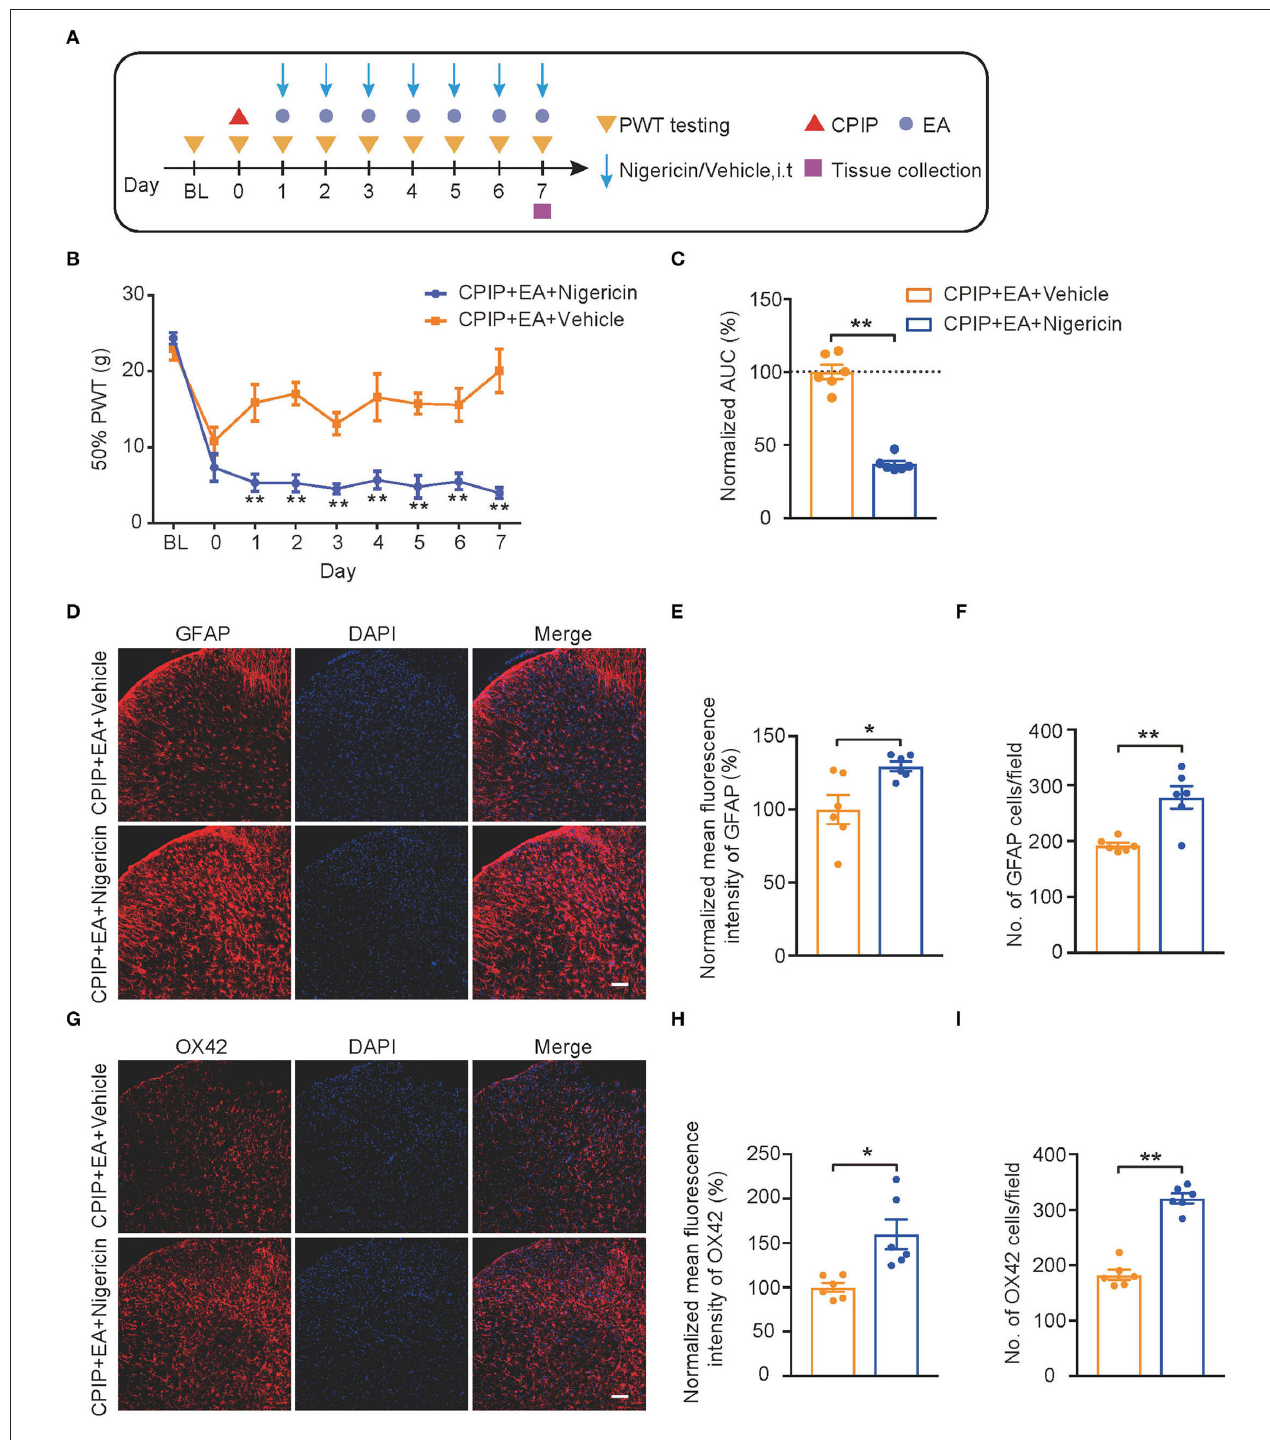
FIGURE 8 | EA-induced anti-allodynic effect in CPIP rats is reversed by NLRP3 inflammasome activator nigericin. (A) Experimental protocol. (B) Time course showing the effect of intrathecal nigericin on EA-induced anti-allodynia in CPIP rats. (C) Normalized AUC deduced from (B) . (D) Immunostaining of GFAP in ipsilateral SCDH after intrathecal nigericin/Veh injection. (E) Summary of the mean fluorescence intensity of GFAP. (F) Summary of the total number of GFAP + cells/observation field. (G) Immunostaining of OX42 in ipsilateral SCDH after intrathecal nigericin/Veh injection. (H) Summary of the mean fluorescence intensity of OX42. (I) Summary of the total number of OX42 + cells/observation field. Scale bar indicates 100 µ m. * p < 0.05, ** p < 0.01 vs. CPIP + EA + Veh group. n = 6 rats/group. Two-way ANOVA with Tukey’s post-hoc test was applied in panel B. Student’s t -test was used in other panels.